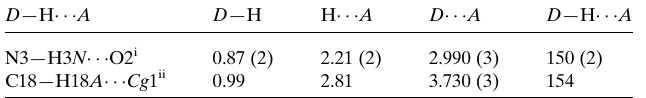
Table 2 Hydrogen-bond geometry (A˚ , (cid:4) ). Cg 1 is the centroid of the (C10–C15) ring.